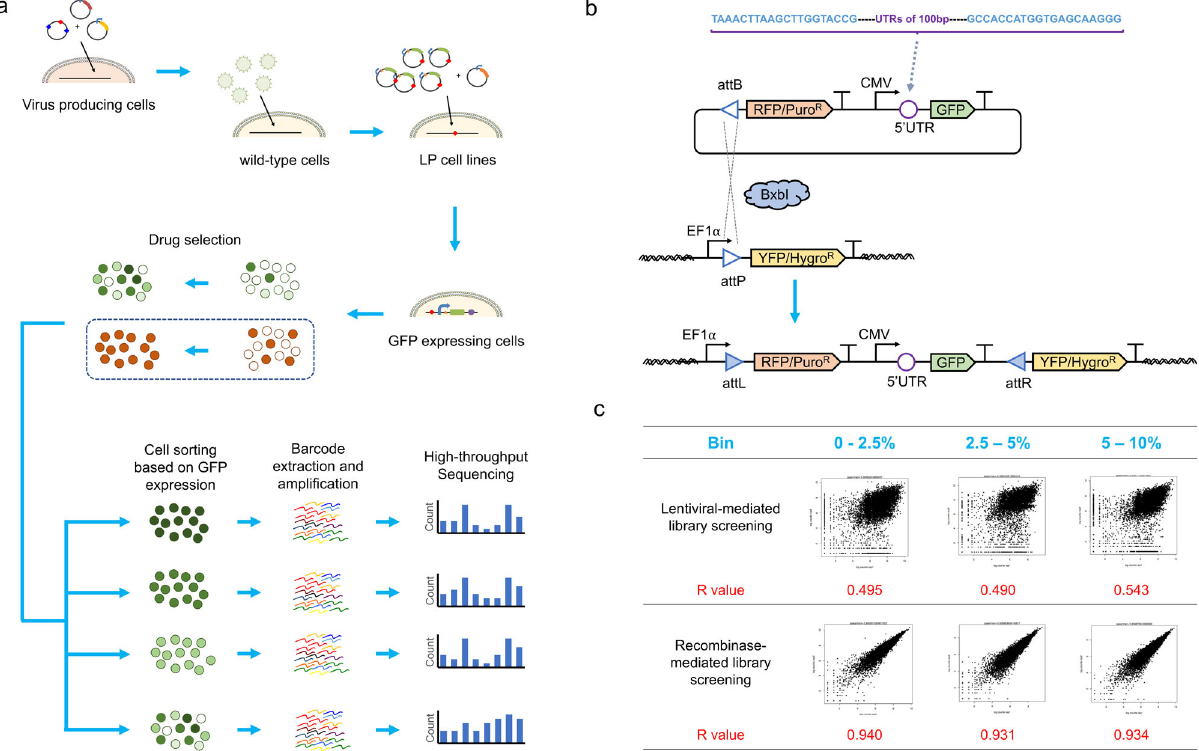
Fig. 3 Strategy for constructing HEK 293T cell lines with a landing pad and screening the 5 ′ UTR library using recombinase-based gene integration. a Recombinase-based library screening work fl ow. b Construction of the 5 ′ UTR library and schematic illustration of recombinase-based gene integration. c We observed high reproducibility for barcode representations between two HEK-LP cell lines independently transfected with the library and a recombinase-expression plasmid; cells were sorted into three bins based on GFP expression (top 0 – 2.5%, top 2.5 – 5%, and top 5 – 10%). log2 values of normalized barcode counts are shown. R is the Pearson correlation coef fi